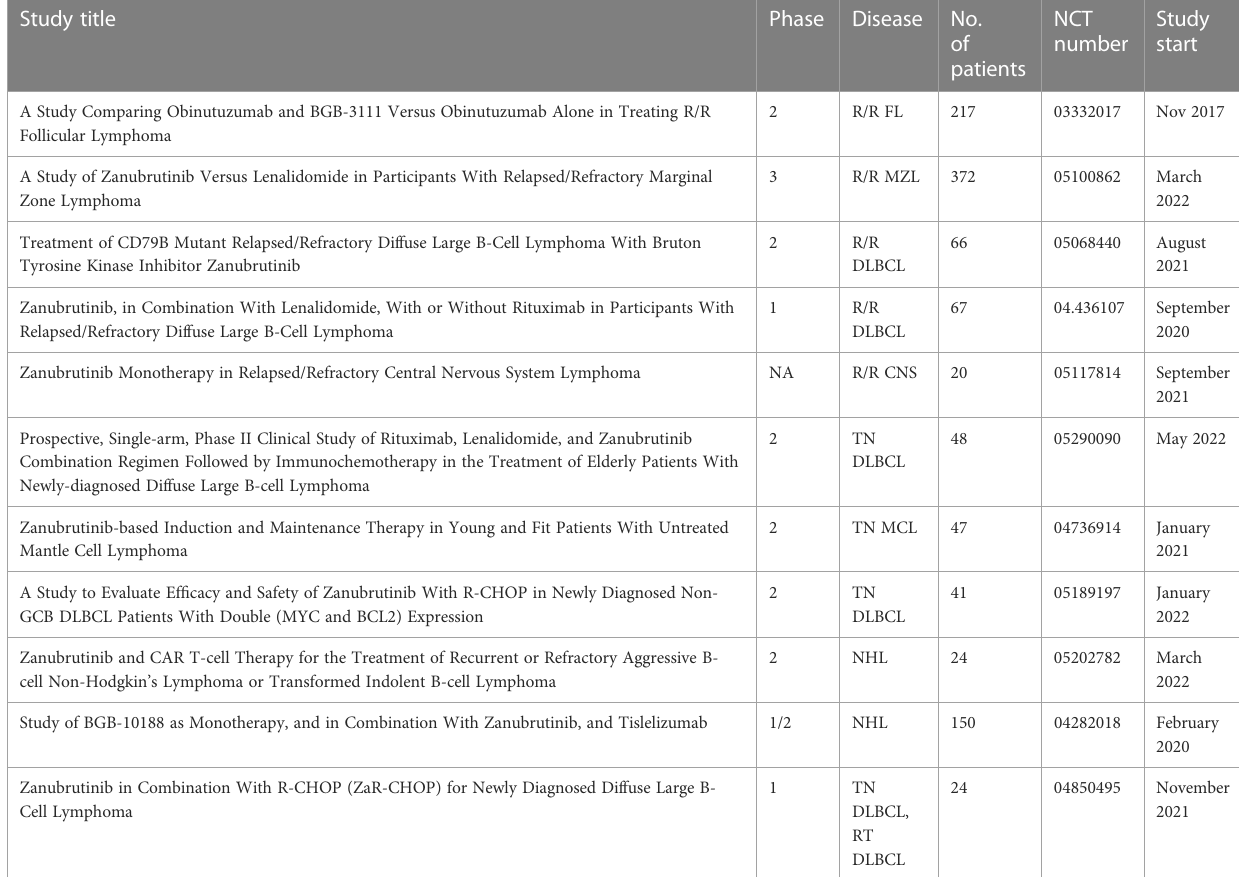
TABLE 2 Ongoing clinical studies with zanubrutinib in lymphoid